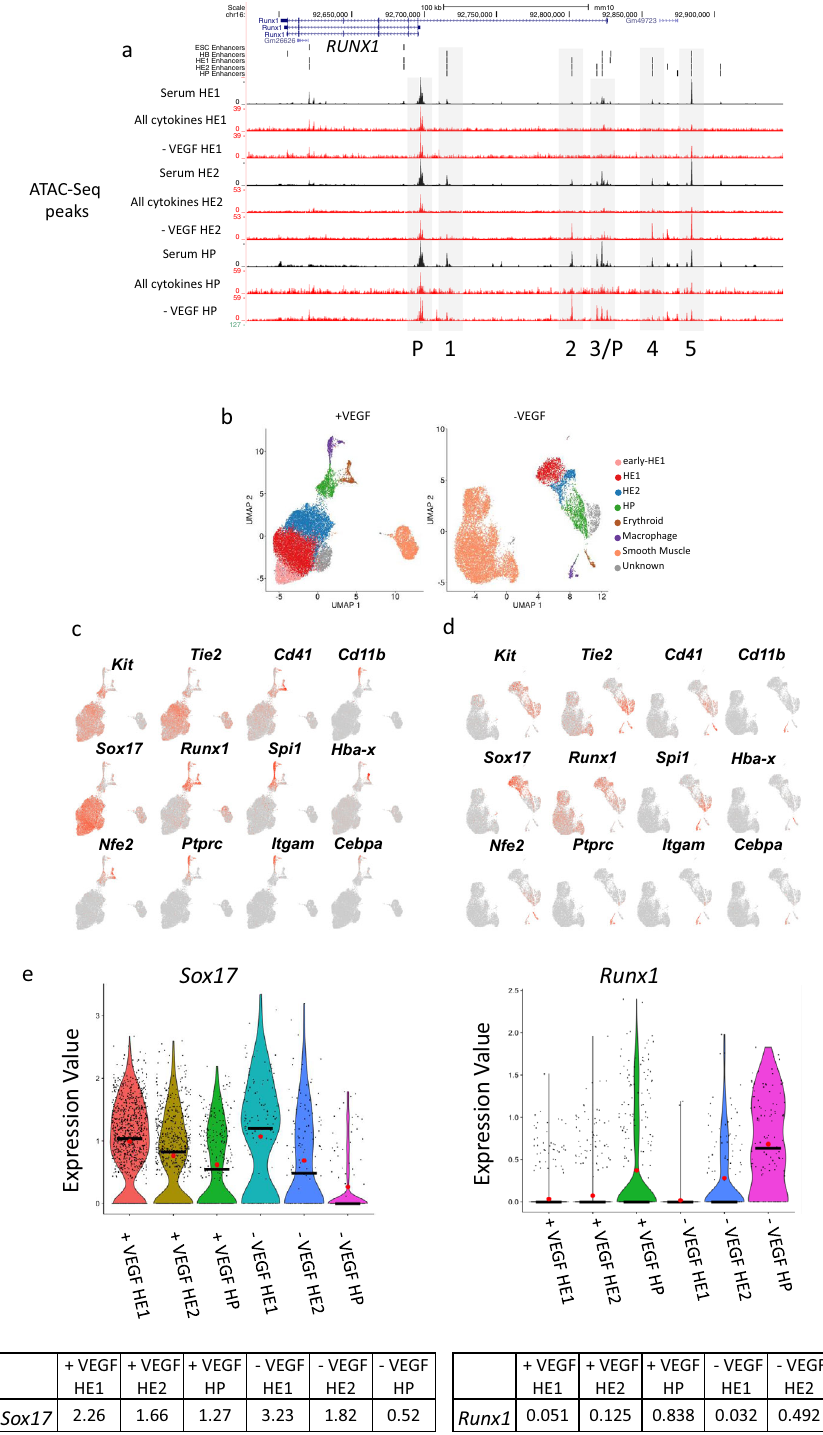
Fig. 6 | VEGF withdrawal shifts the proportion of endothelial/smooth muscle and hemogenic endothelium/blood progenitor cells by blocking Runx1 up- regulation. a UCSC genome browser screenshot depicting open chromatin regions and the locations of distal elements scoring positive in our assay (vertical bars) in the Runx1 locus under the indicated culture conditions (Serum culture, Serum-free with all cytokines and without VEGF (-VEGF)) and at the different developmental stages. Enhancers (numbered 1 − 5) and promoter elements (P) are indicated by blue boxes. Enhancer 2 is located at +23kb, enhancer 3 is at +3.7kb. b Singlecellgeneexpressionanalysiswithpuri fi edHE1andHE2populationsinthe